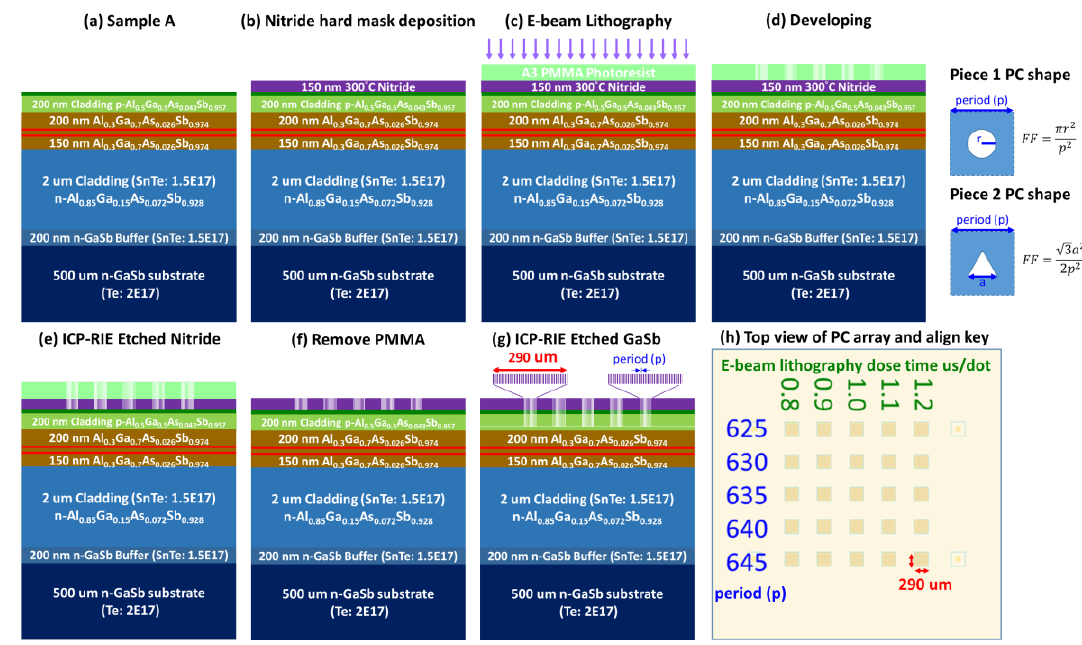
Figure 3. Fabrication process of PCSEL device based on sample A. ( a ) Epitaxy structure; ( b ) deposition